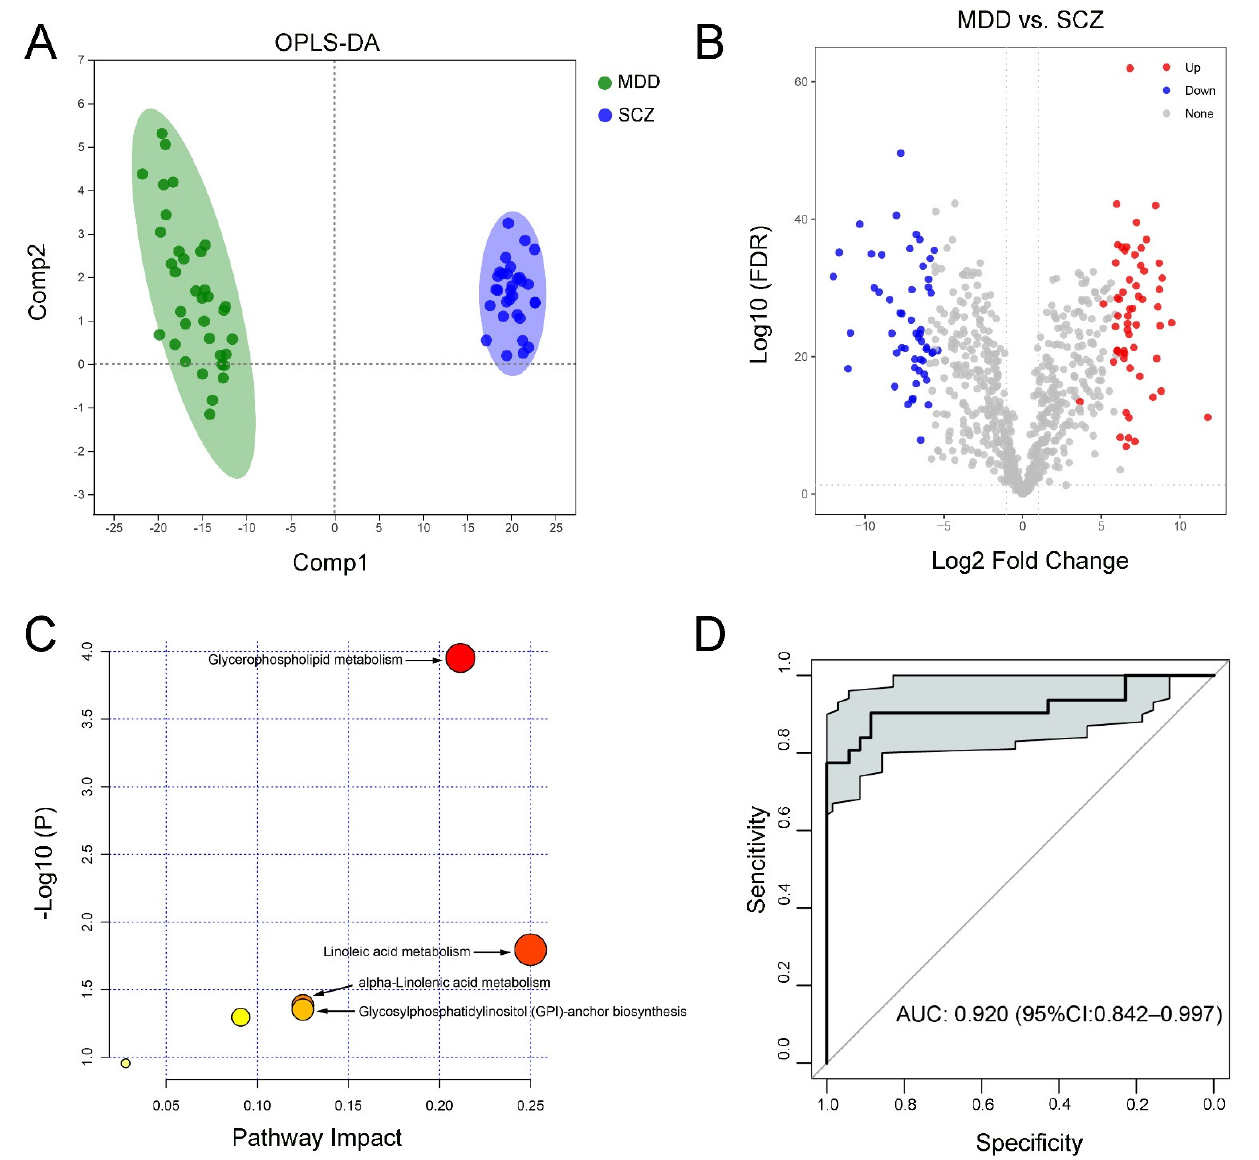
Figure 4. Differential lipid species and their functions between MDD and SCZ participants. ( A ) OPLS-DA model for MDD and SCZ, ( B ) volcano map showed differential species (red dots indicated the increased lipid species and blue dots indicated the decreased lipid species) between MDD and SCZ, ( C ) KEGG pathway enrichment analysis, and ( D ) ROC analysis for the combinational lipids.